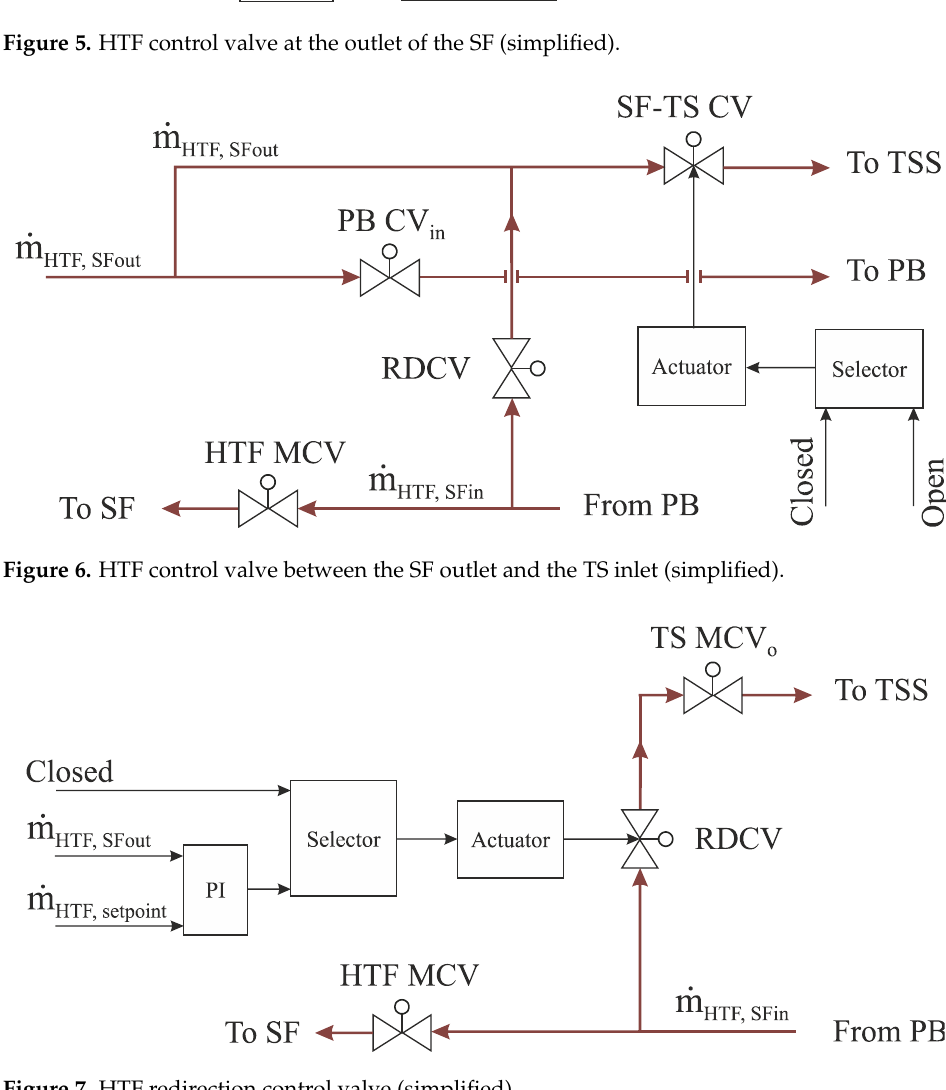
Figure 7. HTF redirection control valve (simplified).